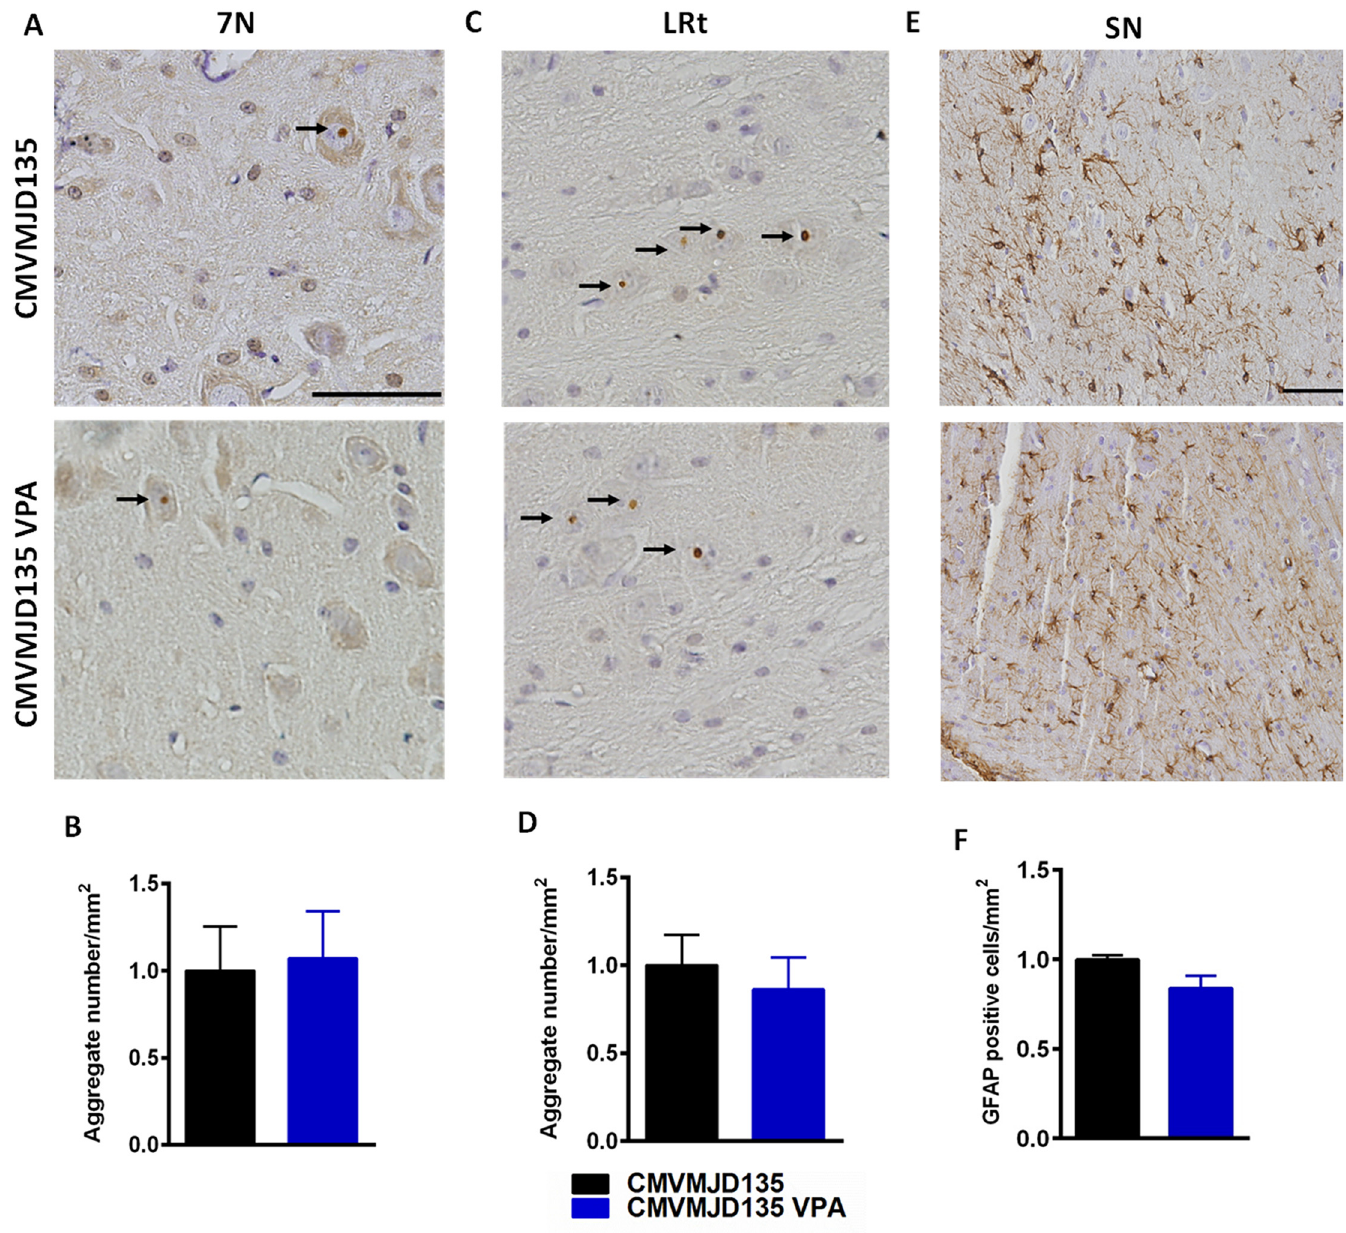
Fig 5. Immnuhistochemistry and quantification of ATXN3 neuronal inclusions and astrogliosis of VPA-treated and non-treated CMVMJD135. No differences in nuclear ATXN3 inclusion load were observed between groups in (A,B) 7N and (C,D) LRt brain regions. No differences in astrogliosis in substantia nigra (SN) between VPA-treated and non-treated transgenic animals (E,F). Scale bar of ATXN3 figures, 20 μ m; Scale bar of GFAP figure, 200 μ m. Bars represent the mean ± SEM (n = 4 for each group), One-Way ANOVA.